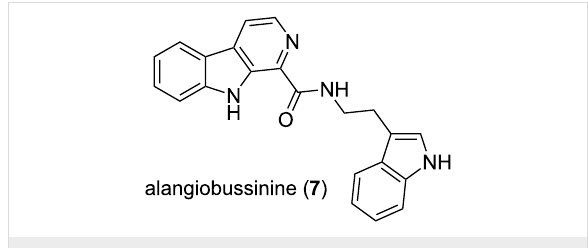
Figure 1: Structure of alangiobussinine ( 7